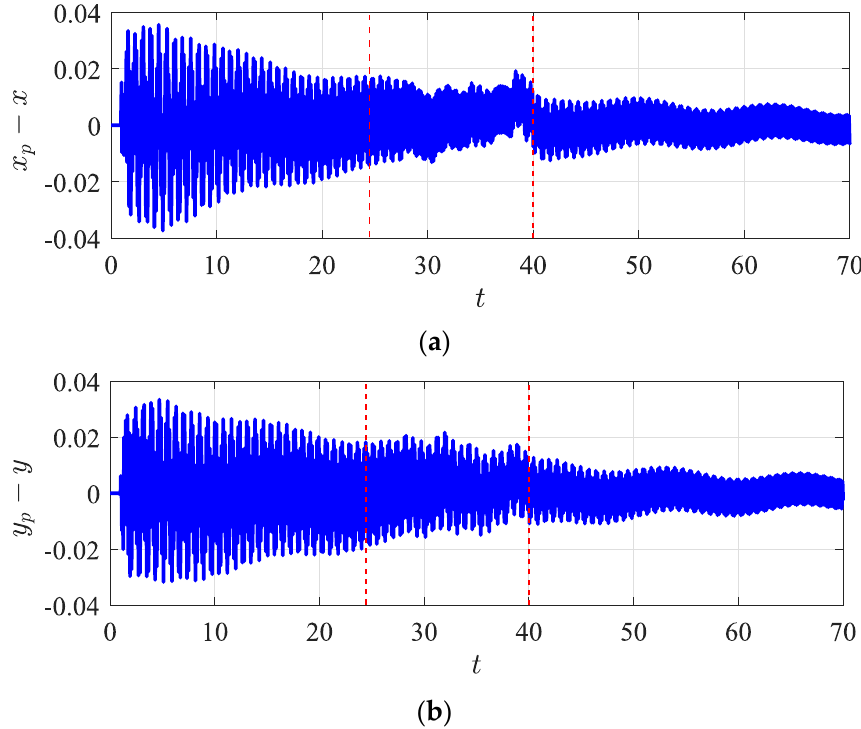
Figure 15. Relative displacements between the quadrotor and its payload along ( a ) x and ( b ) y directions. Thus, a smooth trajectory (i.e., slower changes in attitude or altitude) reduces the undesired relative trajectory and its swing load influence. Table 3 exhibits the ratio values for relative displacements between circular and rectangular trajectories ( R T ) along the x direction. The mass ratio é is also calculated using the following relationship ( p m = m p / m ) , while the stiffness is changed proportionally to maintain the natural frequency of the payload at 5 Hz. Table 3. RMS percentagex of relative displacement, using both trajectory configurations (rectangular and circular).